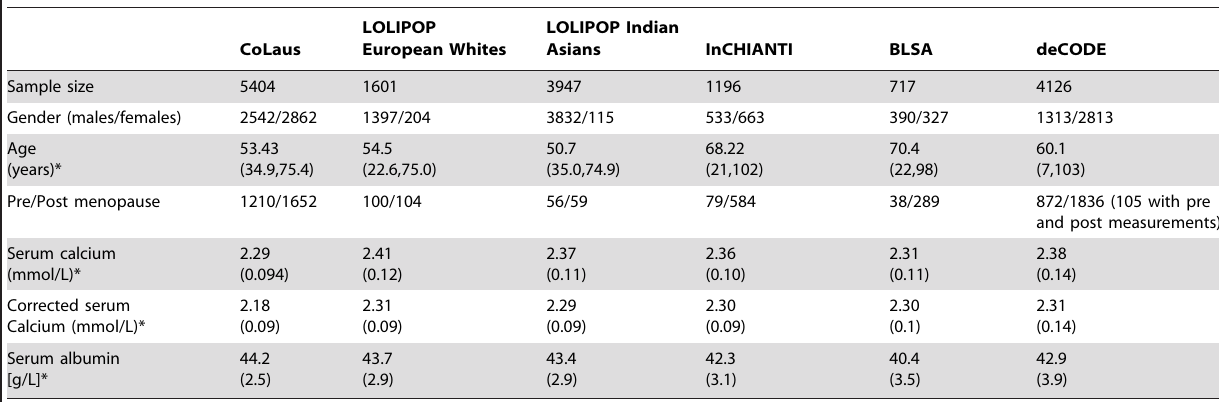
Table 2. Characteristics of participants, by